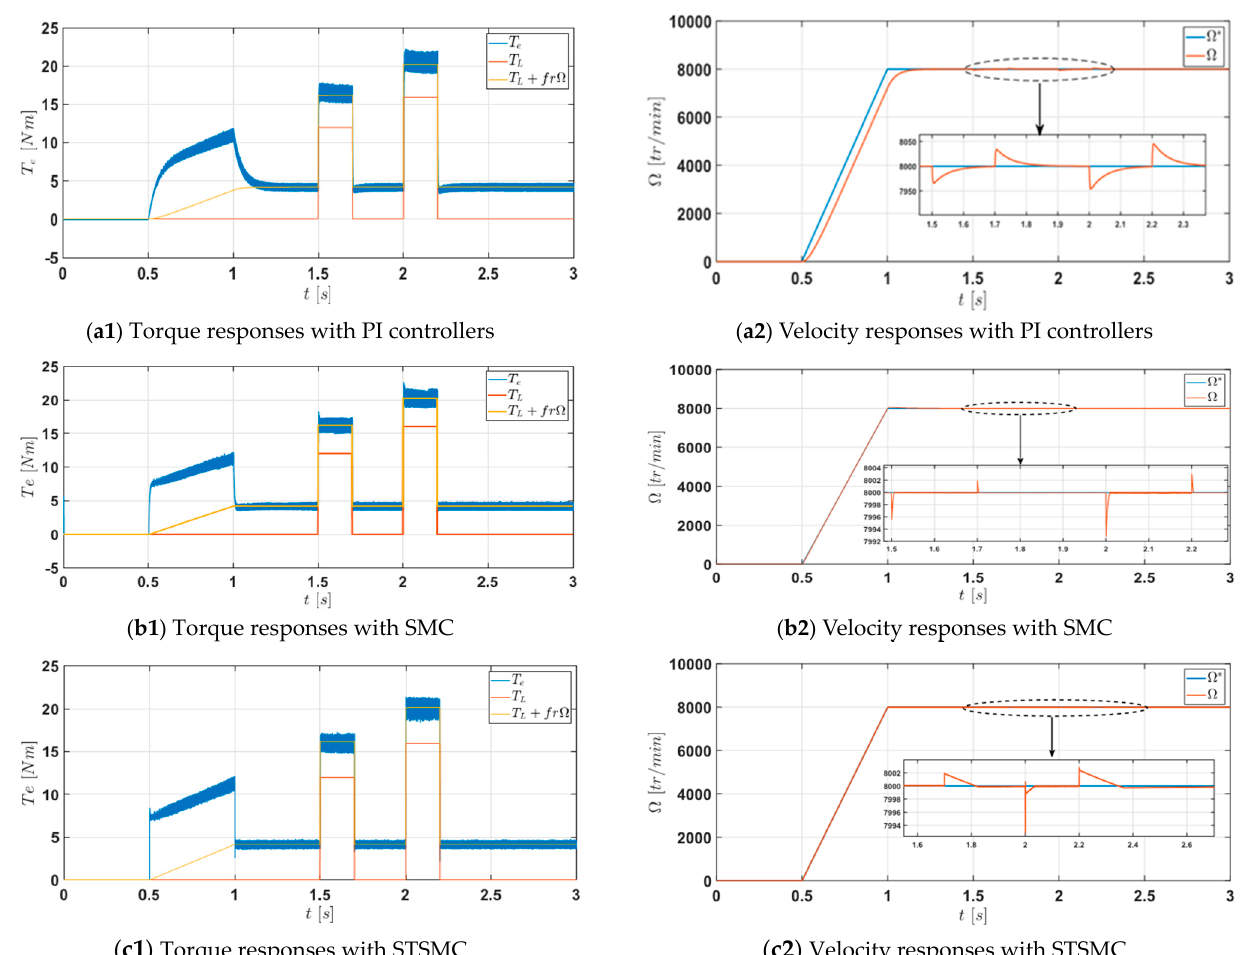
Figure 10. Velocity and torque responses with the three controllers.